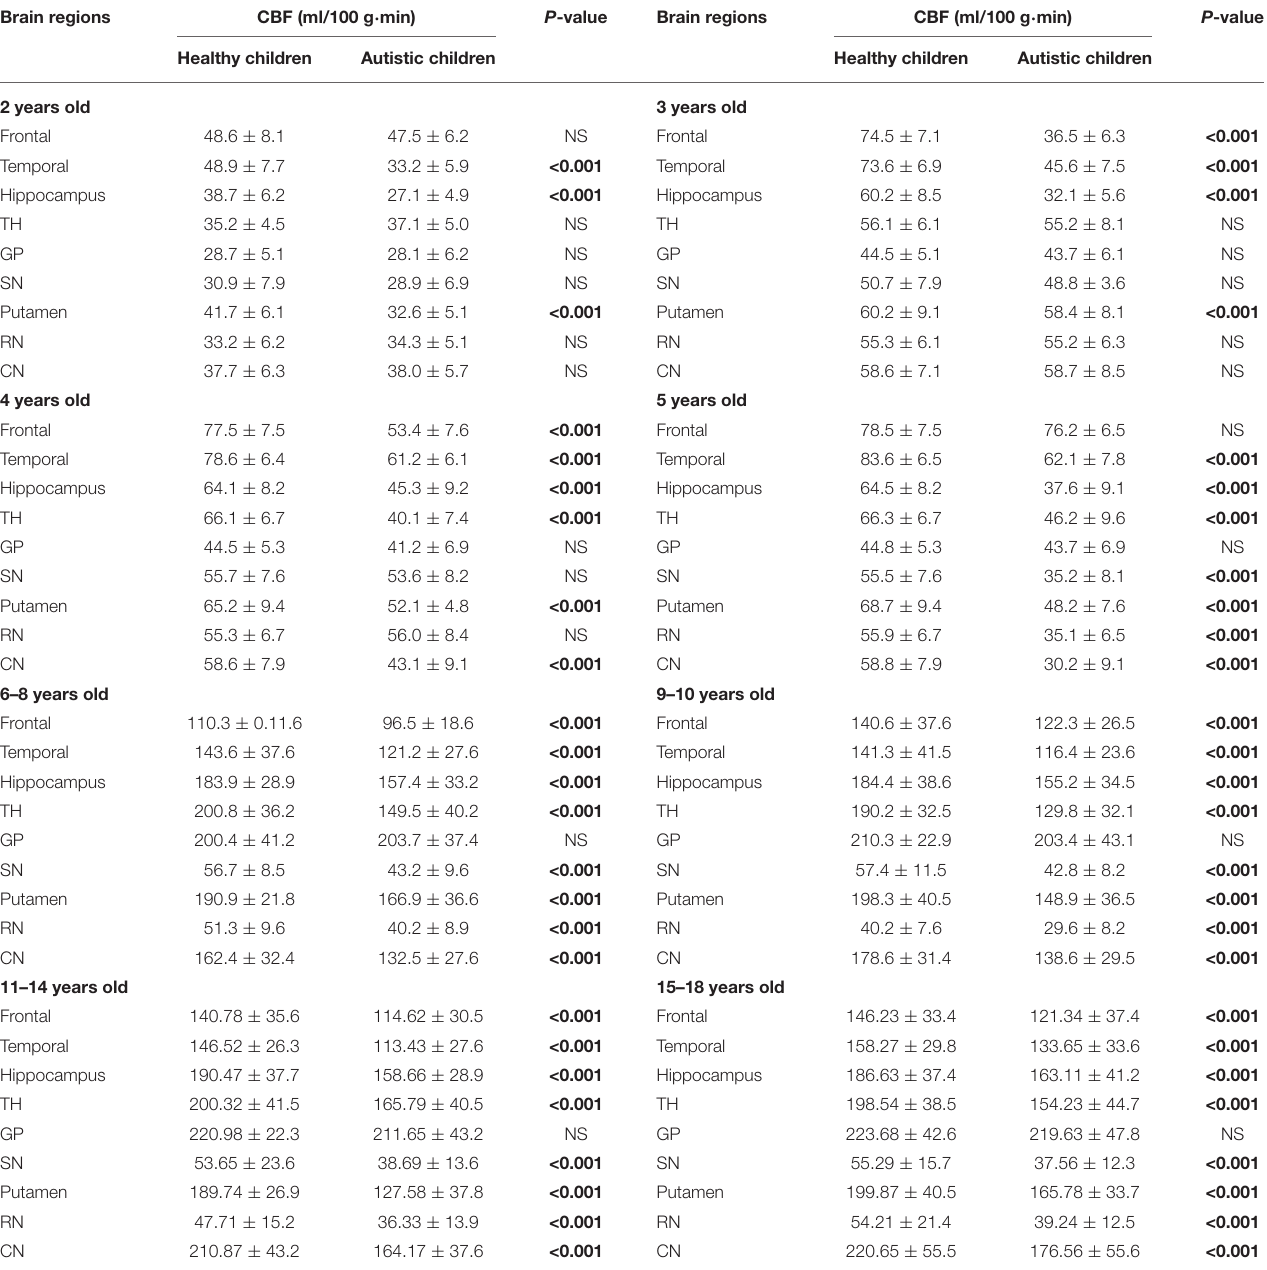
TABLE 2 | CBF values of brain regions in children [CBF (ml/100 g · min), x ± s, n = 40]. Brain